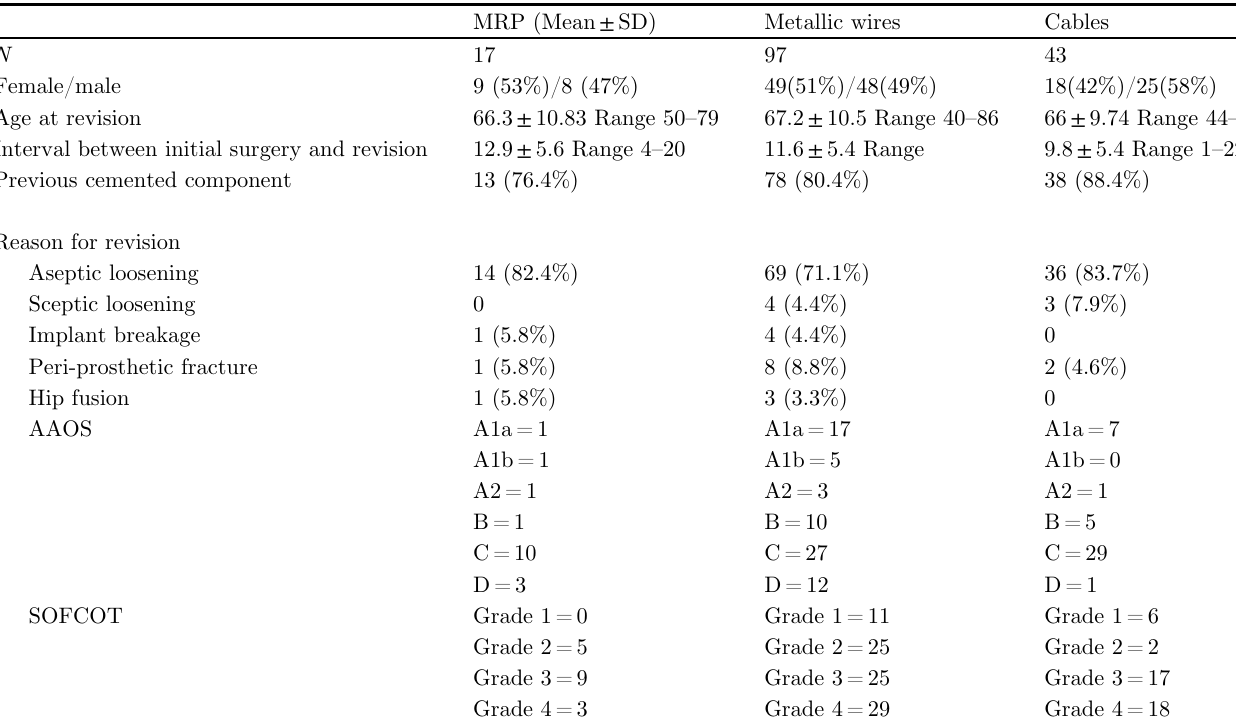
Table 1. Demographic data.